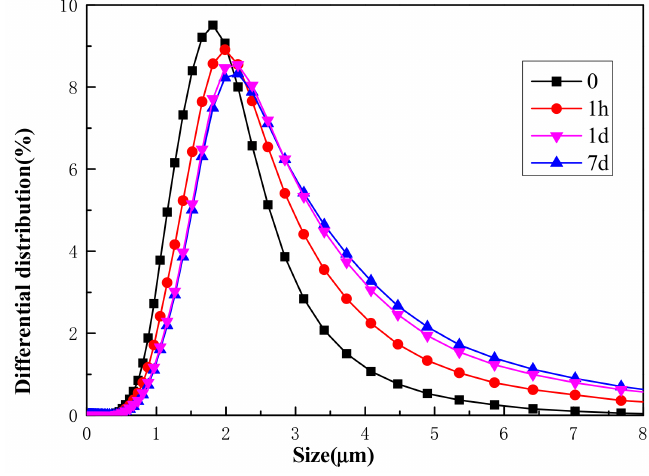
Figure 6. PSD of BaSO 4 at different Ostwald ripening.